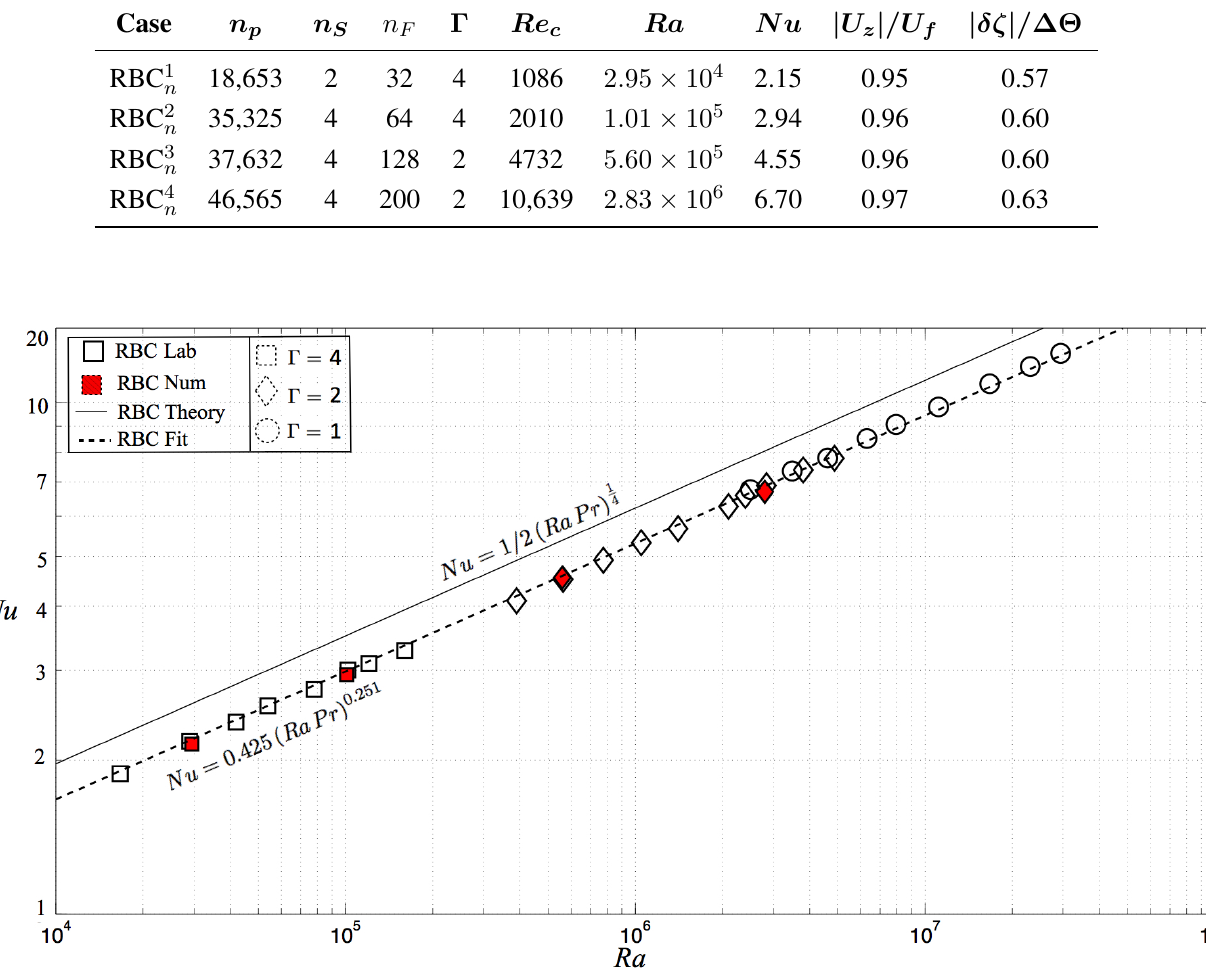
Table 4. Input and output parameters for the numerical RBC cases. The Prandtl number has a fixed value of P r = 0 . 025 . The number of meridional grid points is n meridional subdomains is n , and the number of azimuthal Fourier modes is n S